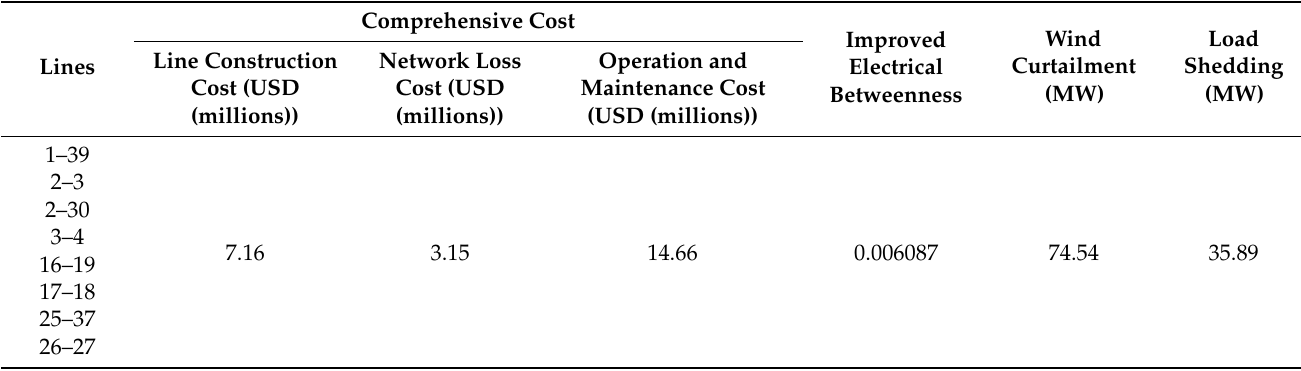
Table 14. TNEP scheme of PSO in modified New England 39-bus system.